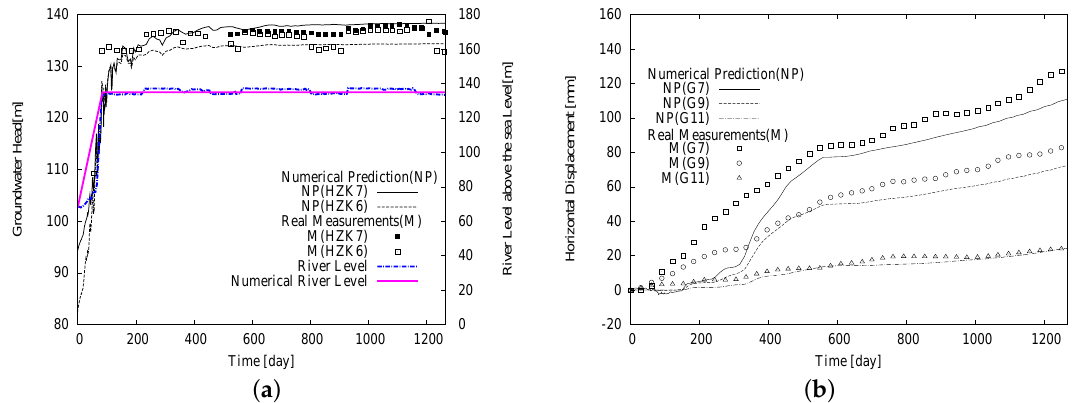
Figure 8. Comparison between the numerical prediction (NP) and the real measurement (M) for ( a ) groundwater level at HZK6, HZK7; ( b ) horizontal displacements at G7, G9,